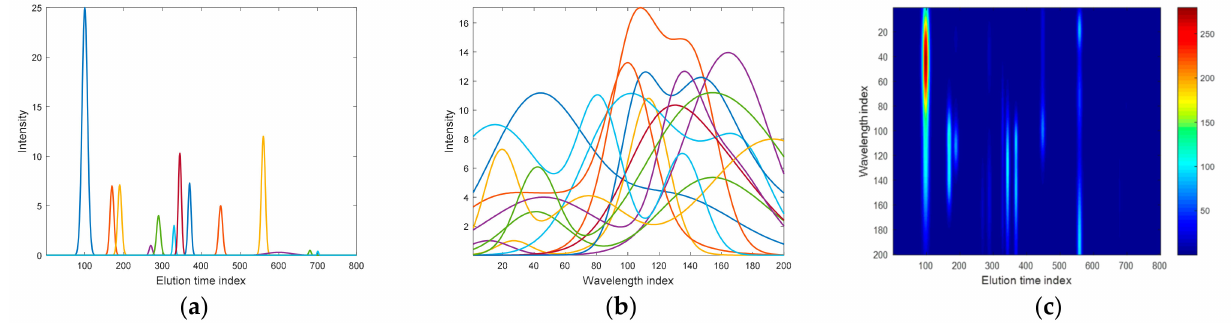
Figure 1. ( a ) Template of 13 signals of pure chromatographic peaks with 800 sampling points, ( b ) template of 13 pure spectral profiles containing 200 sampling points, and ( c ) a resulting second-order chromatographic signal for the exemplary sample from the first